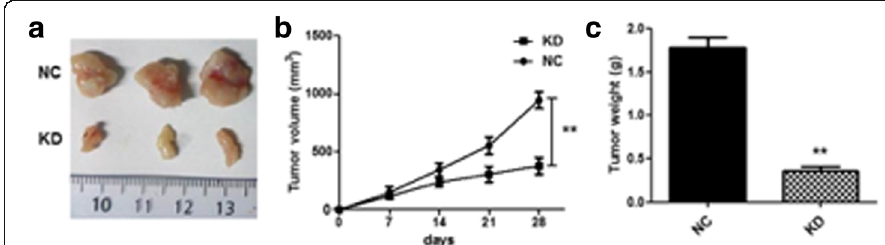
Fig. 5 Effect of SNHG8 knockdown on EBV-associated GC growth in vivo. A subcutaneous xenograft tumor model of GT38 cells in nude mice was established. GT38 cells were transfected with sh-NC (CON group) or sh- SNHG8 (KD group; n =6). a Tumors in mice inoculated with GT38 cells treated with sh-NC or sh-SNHG8. b Tumor size in the two groups. c Tumor weight in the two groups. ** p <0.01 compared with the CON